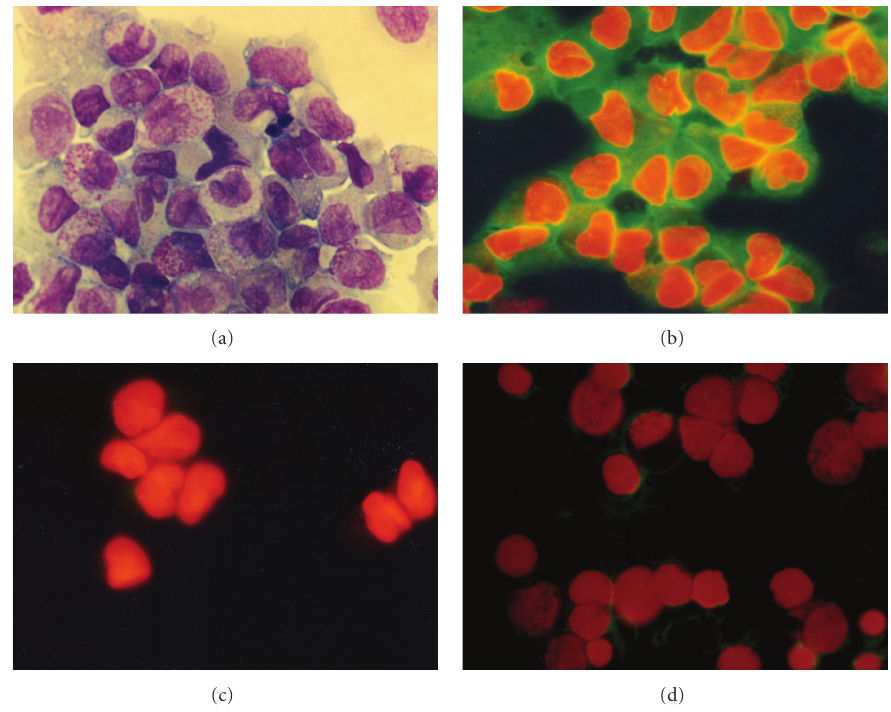
Figure 6: Expression of A2 is specifically elevated in acute promyelocytic leukemia cells. (a) Wright-Giemsa stain of human acute promyelocytic leukemia (APL) cells (M3). (b) APL cells stained with anti-A2 antibody (green fluorescence) and counterstained with ethidium bromide to visualize nuclei. (c) APL cells stained with nonimmune IgG and ethidium bromide. (d) Undi ff erentiated leukemia cells (M0) stained with anti-A2 antibody and ethidium